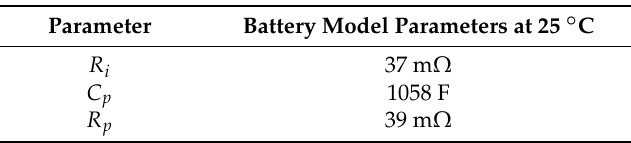
Table 2. As a result, the value of matrix A and B in Table 1 remains unchanged in this study. Table 2. Parameters of simplified battery